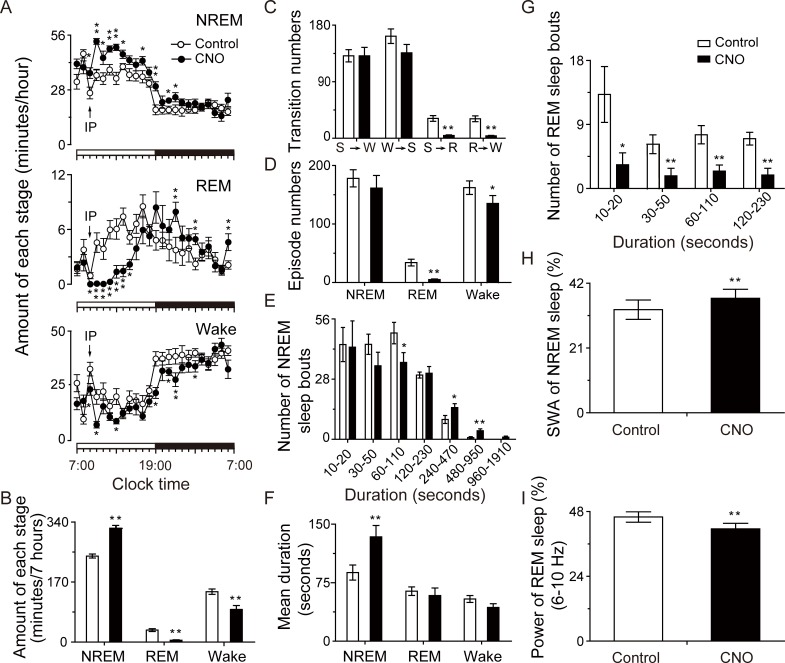
Pharmacogenetic activation of rostromedial tegmental nucleus (RMTg) neurons increased non-rapid eye movement (NREM) sleep in rats.(A, B) Sleep–wake quantities following saline and clozapine-N-oxide (CNO) injection, including average hourly (A) and total sleep–wake amounts (B) during the post-injection period (09:00–16:00 hours). (C–G) Sleep–wake architecture during the post-injection period (09:00–16:00 hours), including conversions between S (NREM sleep), W (wakefulness), and R (REM sleep) stages (C), episode numbers of sleep–wake stages (D), number of NREM and REM sleep bouts with different duration (E, G), and mean duration of sleep–wake stages (F). (H, I) Average slow-wave activity (SWA) of NREM sleep (H) and electroencephalogram (EEG) power of REM sleep in the frequency range of 6–10 Hz (I) during the post-injection period (09:00–16:00 hours) following saline and CNO injection. *p < 0.05, **p < 0.01 versus saline by paired t tests. CNO (0.3 mg/kg) was given by intraperitoneal (IP) injection at 09:00 hours (n = 9). The horizontal open and filled bars on the x-axes indicate the 12-hour light period and the 12-hour dark period, respectively. Underlying data can be found in S1 Data.